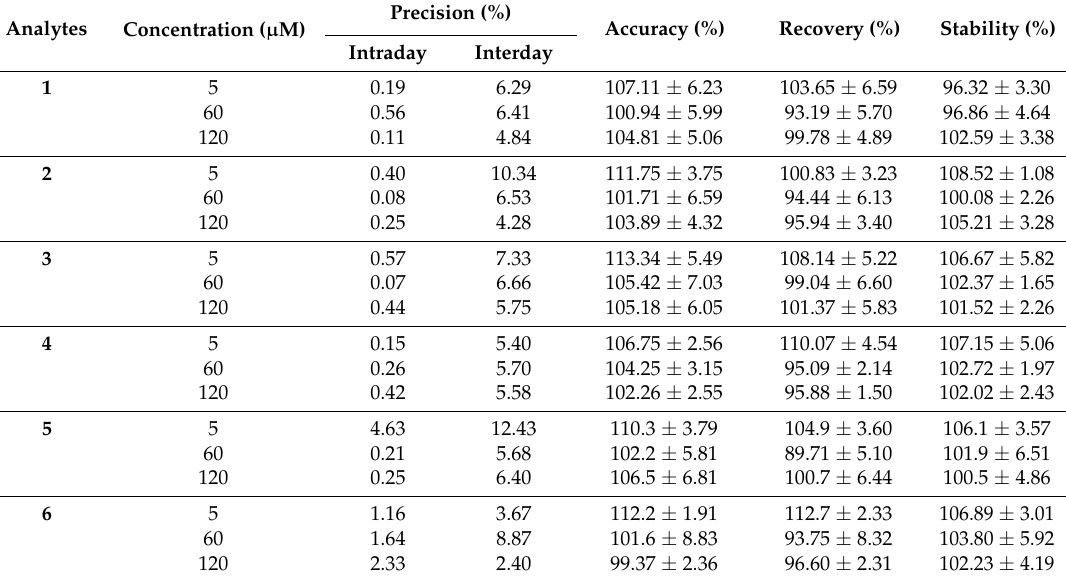
Table 3. HPLC methodological evaluation data of alkaloids 1 – 6 .